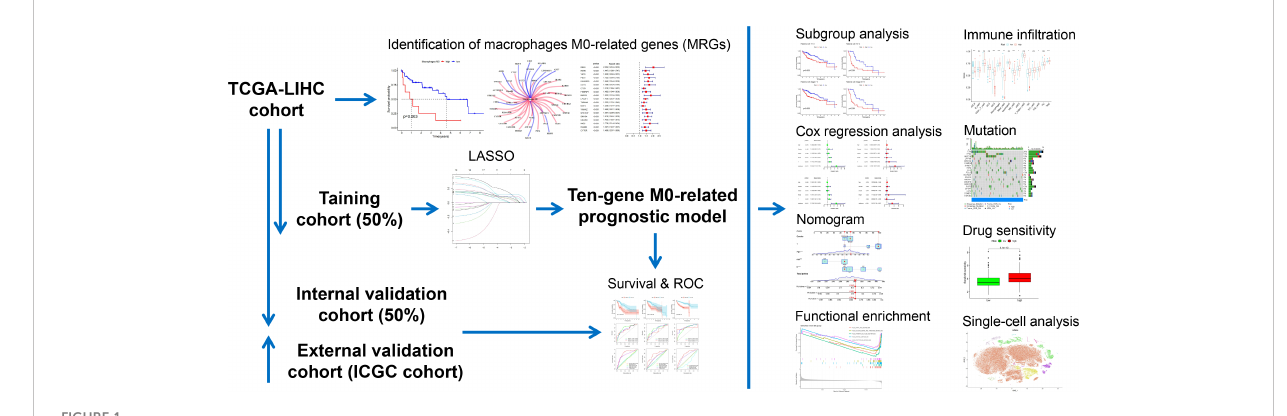
FIGURE 1 Work fl ow of the present